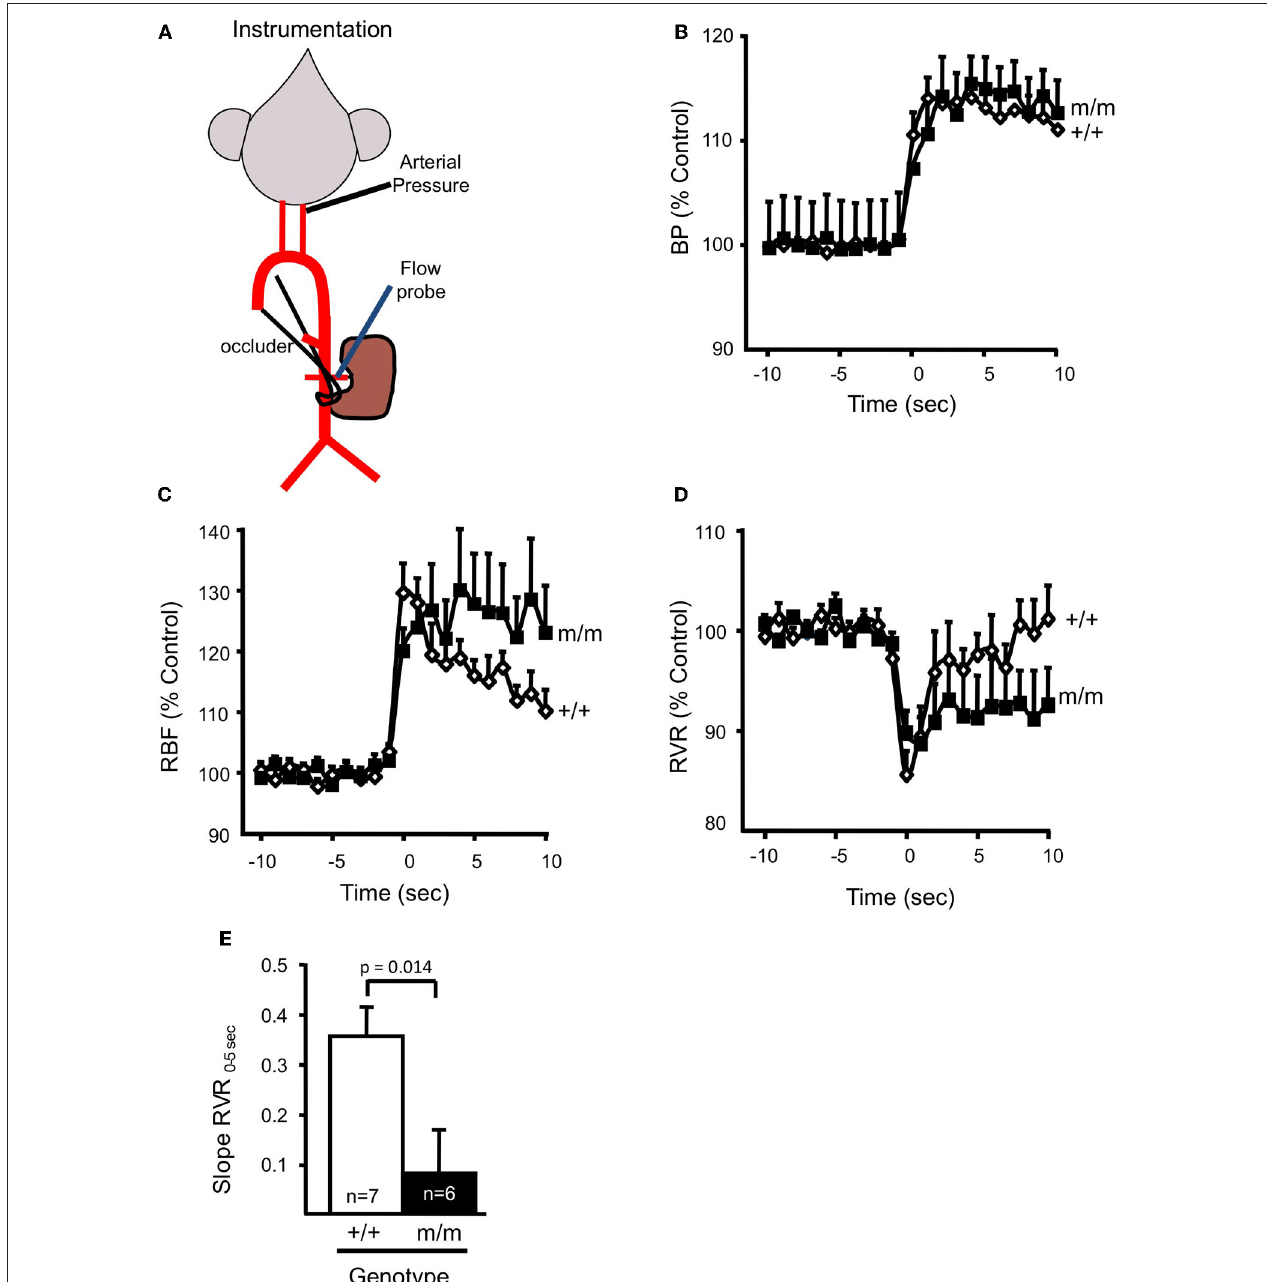
FIGURE 5 | β ENaC mediates myogenic regulation of whole kidney blood flow and renal vascular resistance. (A) Schematic of animal preparation. Mice have an arterial carotid catheter for blood pressure measurement and a renal flow probe for whole kidney blood flow measurement. An occluder tie placed around the lower abdominal aorta is used to generate the step increase in pressure. (B) Time course of the regulatory response of mean arterial pressure (MAP; B ), renal blood flow (RBF; C ), and renal vascular resistance (RVR; D ), in wild type ( + / + , filled symbols, n = 6) and mutant (m/m, open symbols, n = 7) 10s before and 10s after the step increase in pressure. Data are presented as normalized changes in B – D to minimize variance. Following a similar increase in MAP, the transient increase in RBF